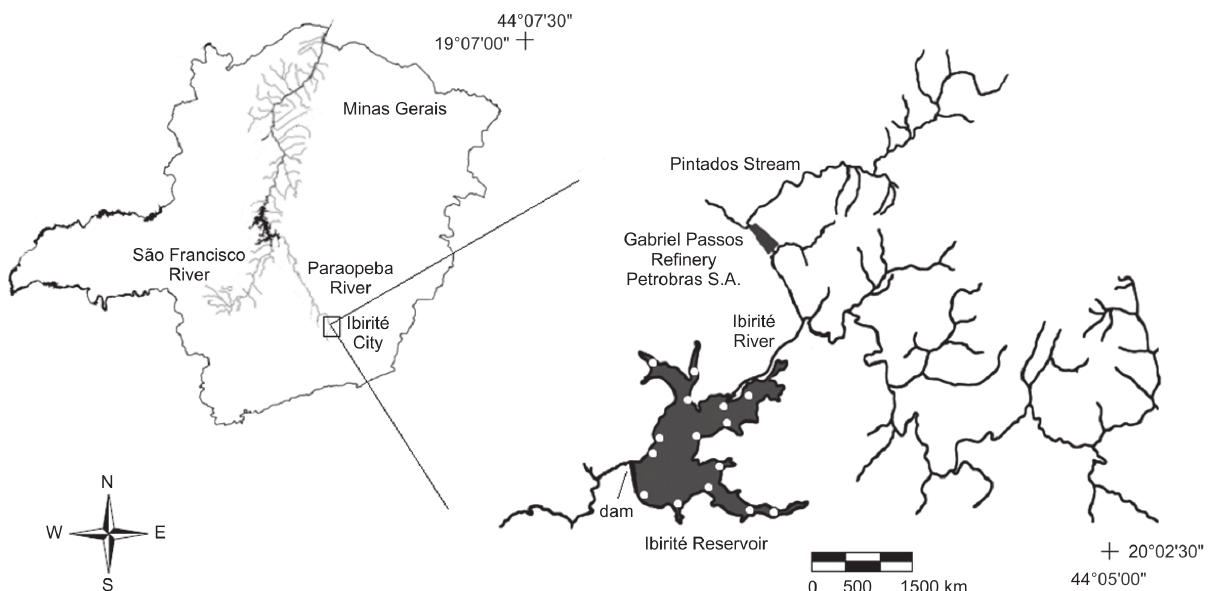
Figure 1. Distribution of sampling points in the Ibirité Reservoir, in the basin of the Paraopeba River, Minas Gerais. Modified from G ARCIA et al.